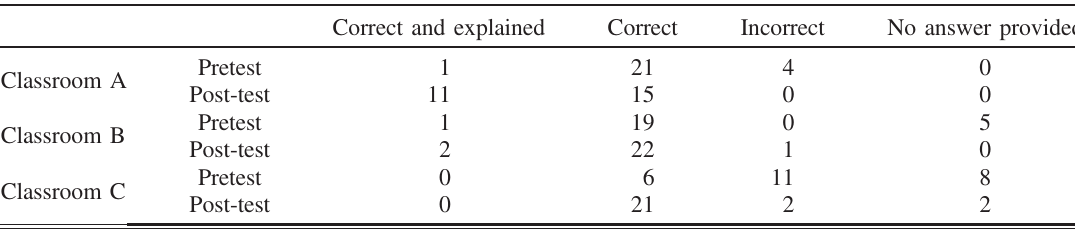
TABLE II. Students ’ answers to question Q2 for both pretests and